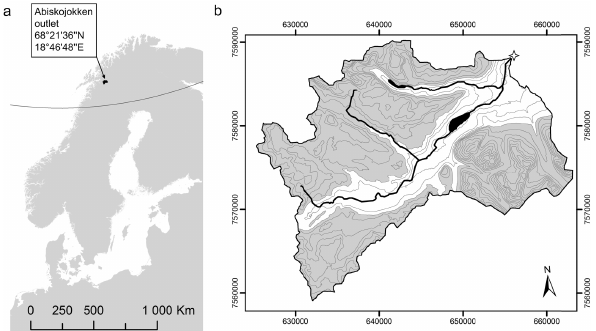
Fig. 1. (a) Map of Scandinavia with Abiskojokken catchment in northern Sweden (marked in black) and the polar circle (marked by line). (b) Site map of Abiskojokken catchment with 73% of the catchment situated above 800ma.s.l. (shaded gray); the outlet is marked by a star (68 ◦ 21 0 36 00 N, 18 ◦ 46 0 48 00 E). The coordinate sys- tem is given in SWEREF